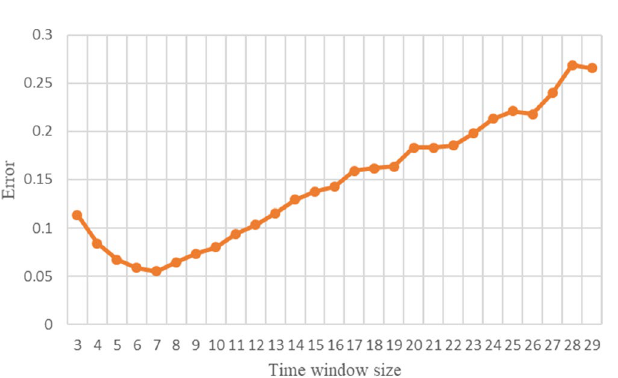
Figure 2. Changes in prediction error when the time window size is 3–29.